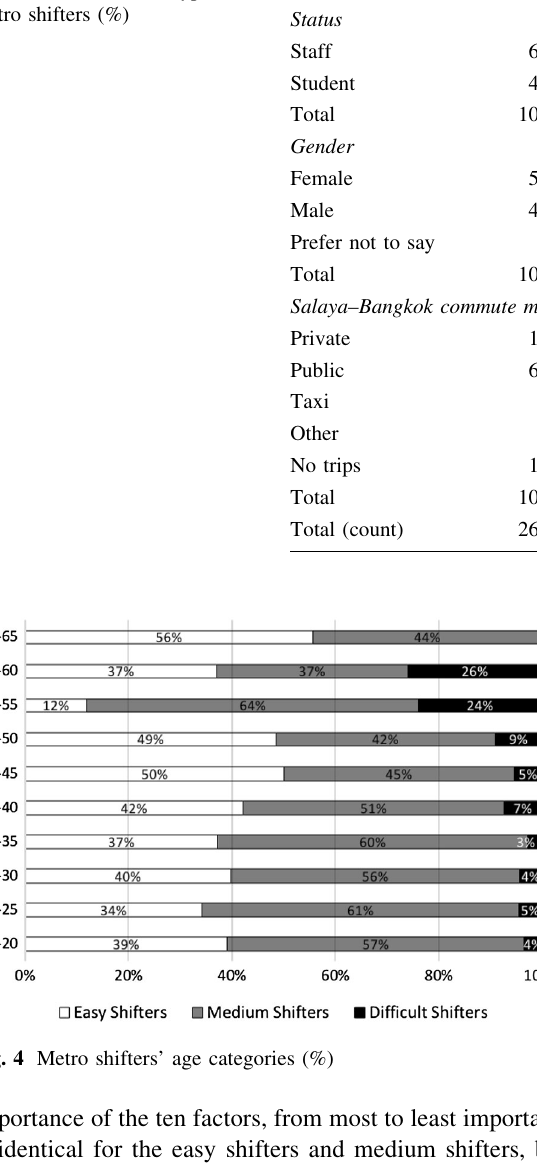
Table 3 Selected characteristics of three types of metro shifters (%)